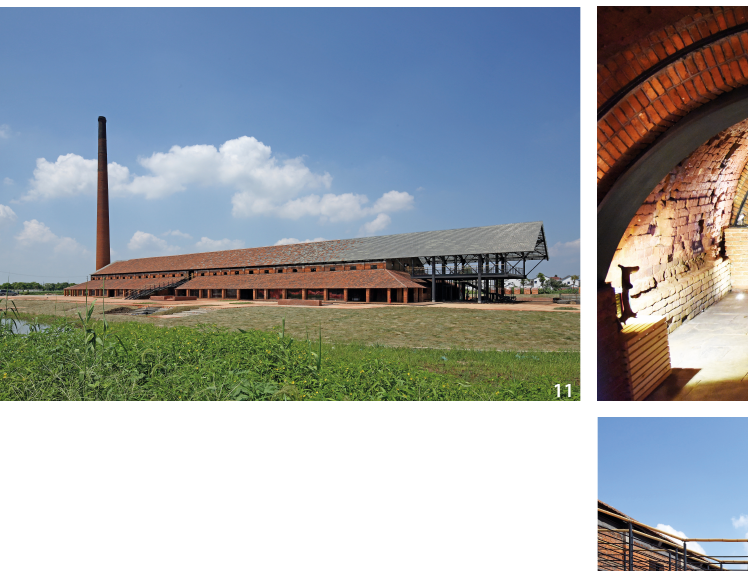
Figure 11 The reconstructed brick and tile factory, designed by Kai Cui Land-Based Rationalism D-R-C, 2016 (Source: Guangyuan Zhang). Figure 12 Brick and tile factory transformed into a dining hall, designed by Kai Cui Land-Based Rationalism D-R-C, 2016 (Source: Haian Guo). Figure 13 Steel stairs leading to the ancient kiln Museum in the second floor, designed by Kai Cui Local Design and Research Centre, 2016 (Source: Guangyuan